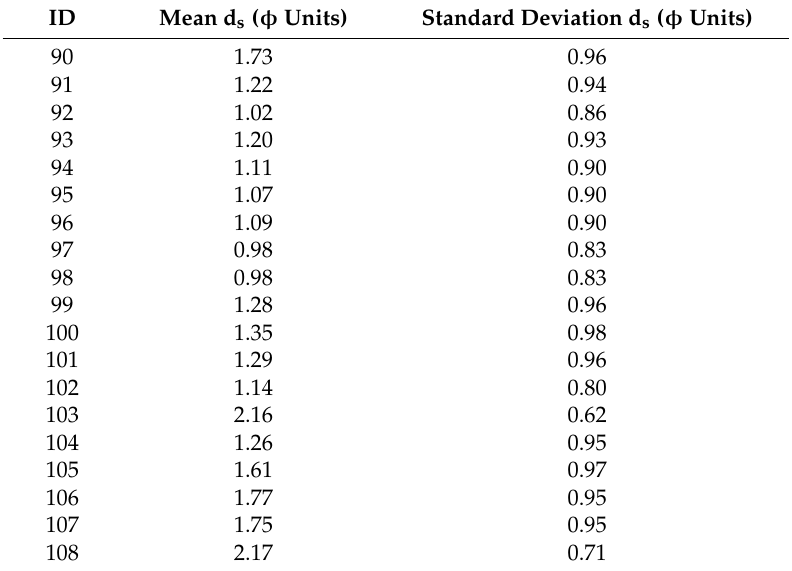
Figure 5. The Guardialfiera Reservoir: highlighting of the cells in which the granulometrical analysis were performed. Table 3. Mean sediment diameter and standard deviation sediment diameter of the granulometric distribution of each sample taken in the Guardialfiera Reservoir, expressed in φ units.